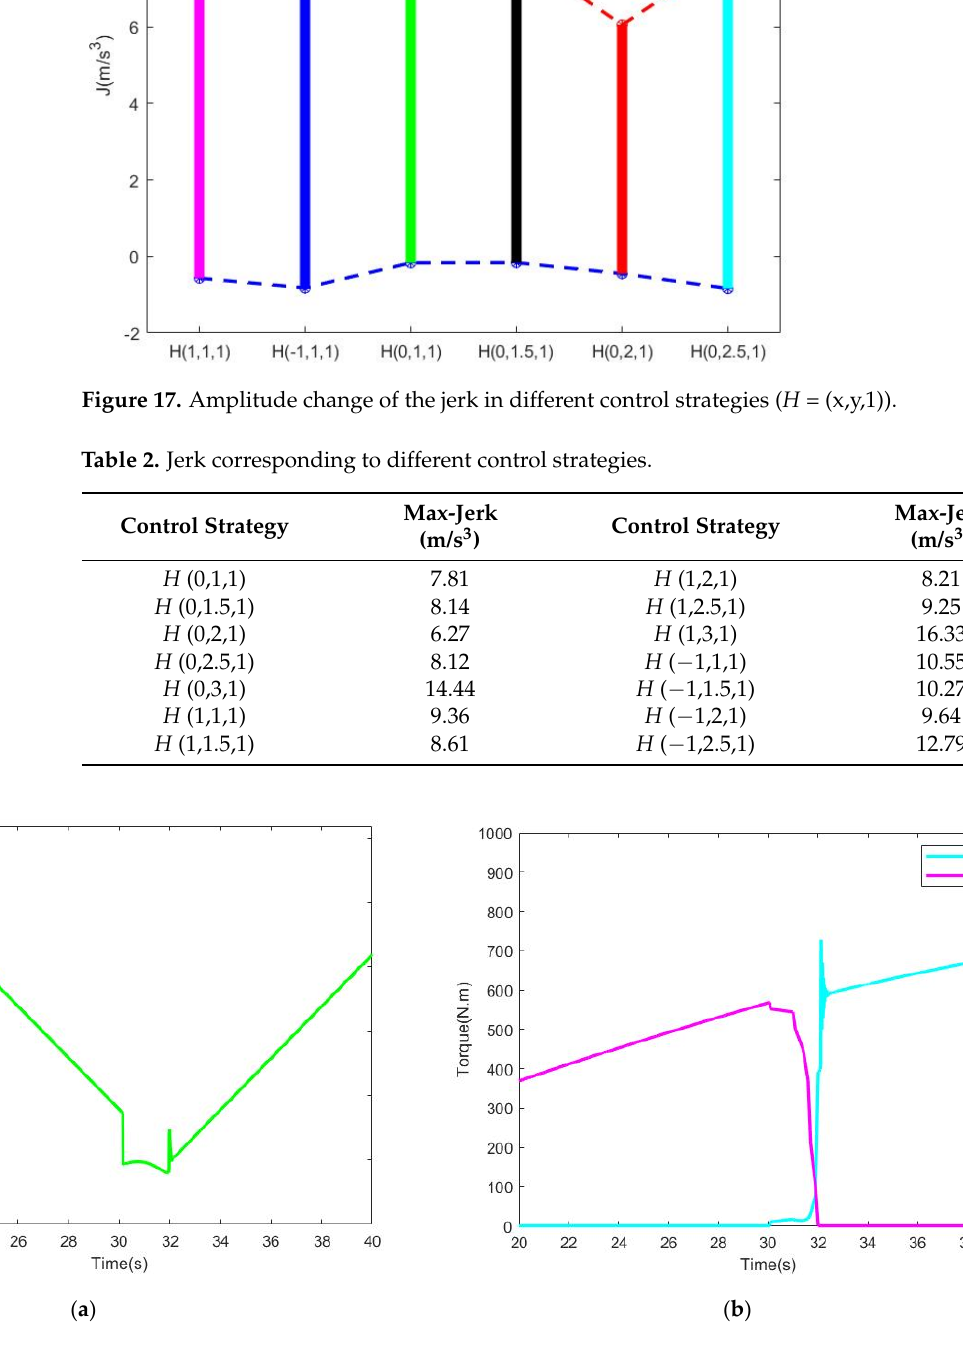
Figure 18. Changes in motor speed and clutch torque when shifting. ( a ) Motor output speed; ( b ) Clutch torque